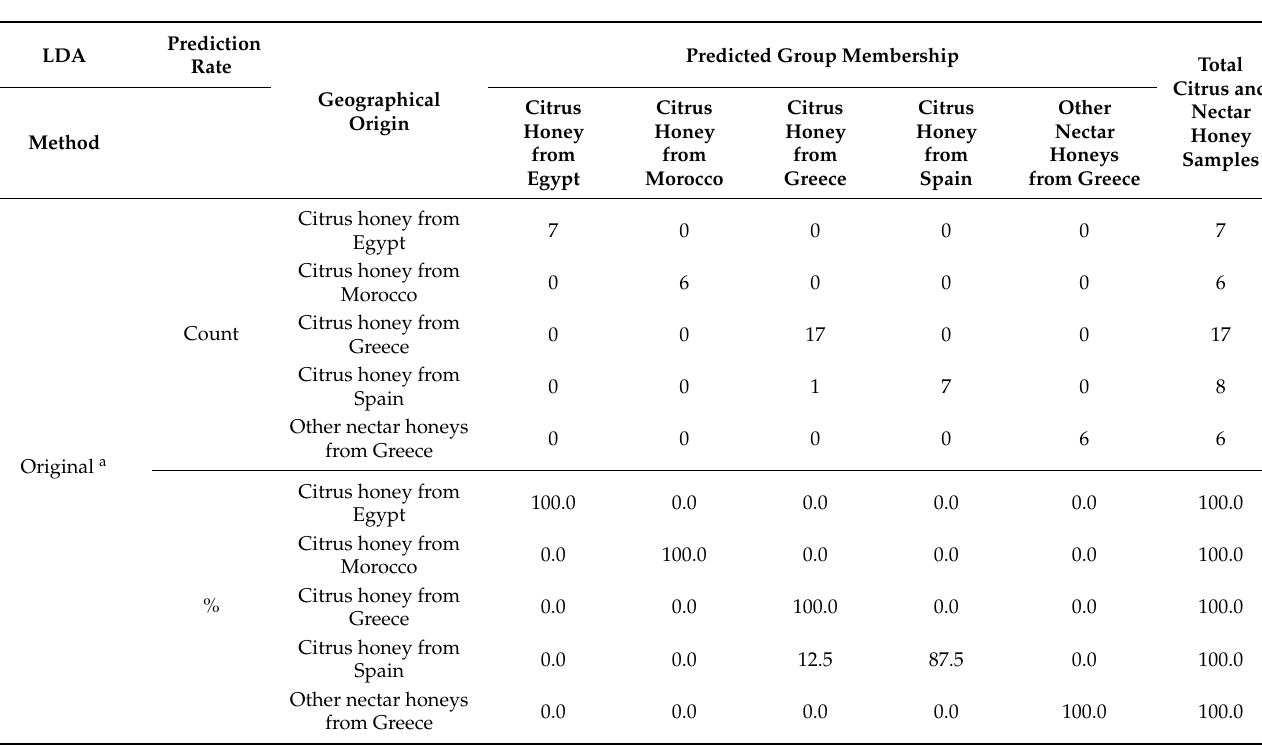
Figure 4. Discrimination of the geographical origin of citrus and other nectar honeys based on volatile compounds and LDA. Table 3. Citrus and nectar honey classification with respect to geographical origin using the significant ( p < 0.05) volatile compounds and